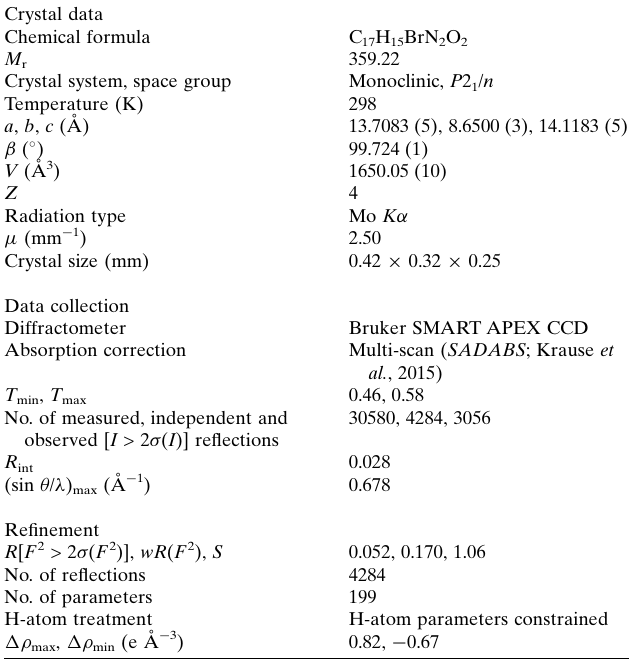
Table 2 Experimental